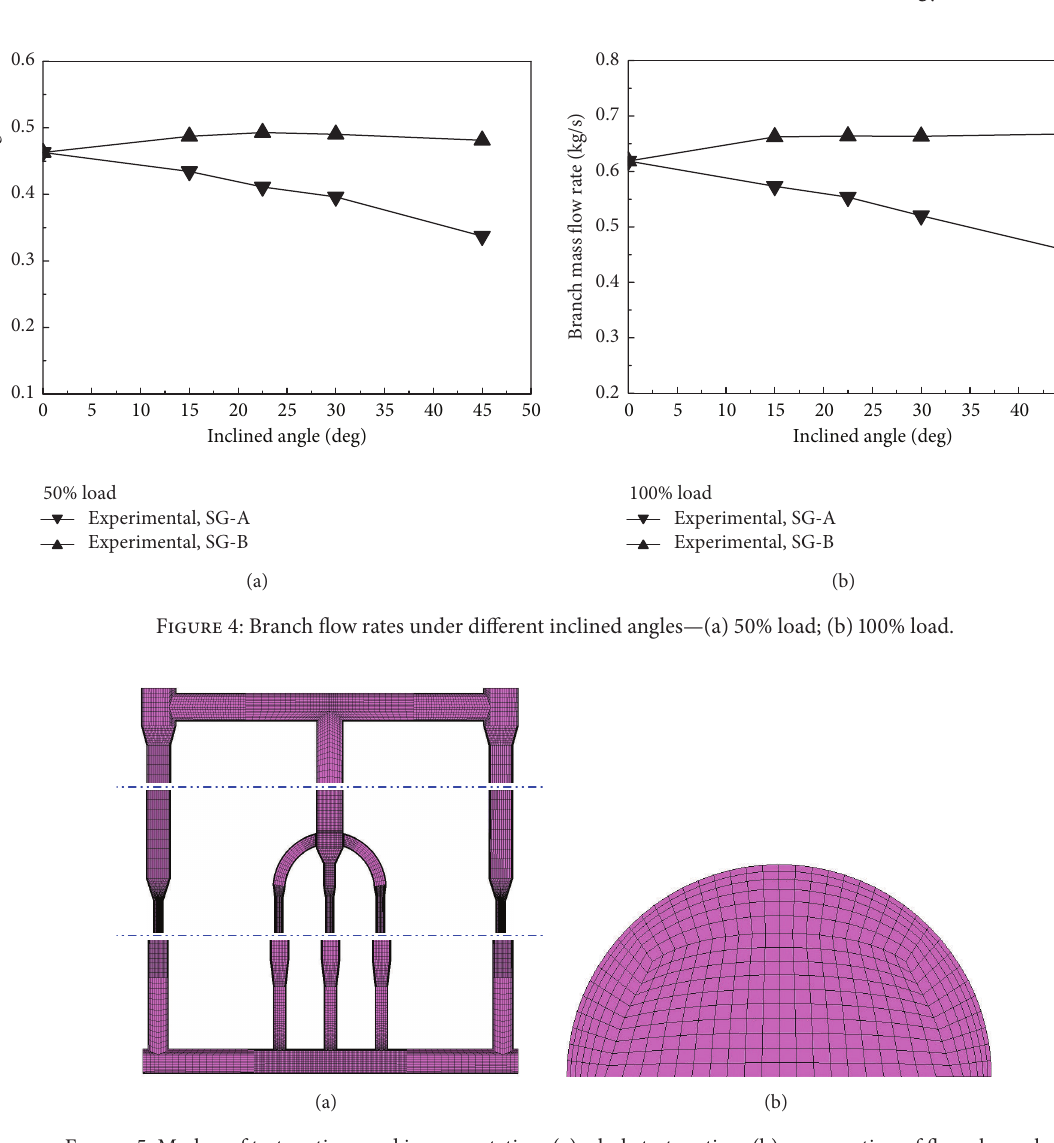
Figure 5: Meshes of test section used in computation: (a) whole test section; (b) cross section of flow channel. Table 1: Comparison of numerical results and experimental results